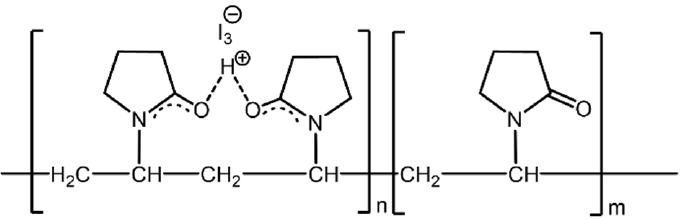
Figure 2. Schematic representation of the structure of the PVPI complex.